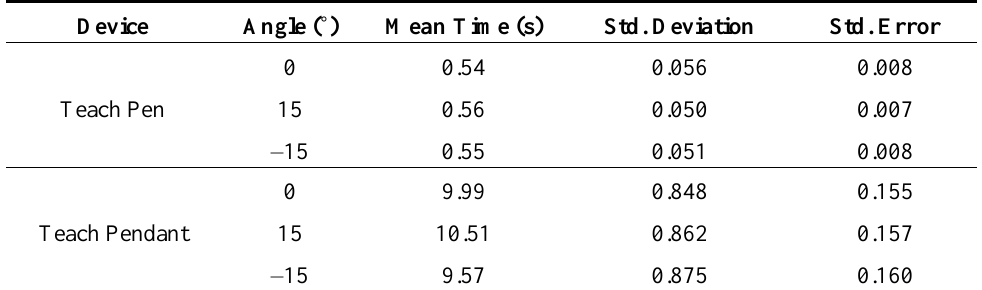
Table 3. Mean time, standard deviation, and standard error operating the two tools at three different inclination angles.